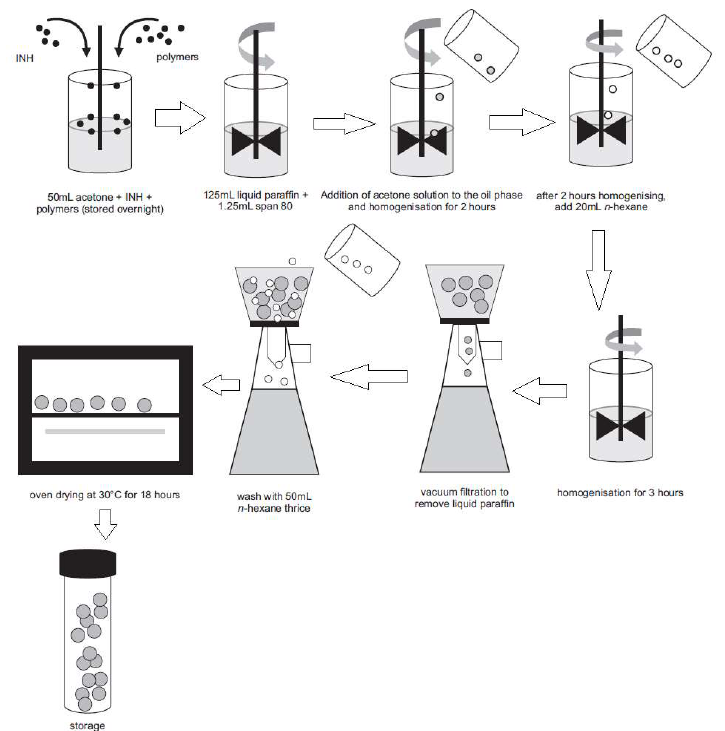
Figure 2. Manufacture of INH microspheres by solvent evaporation. Adapted from Khamanga et al. [21]. Dissolution Technologies, 2009.